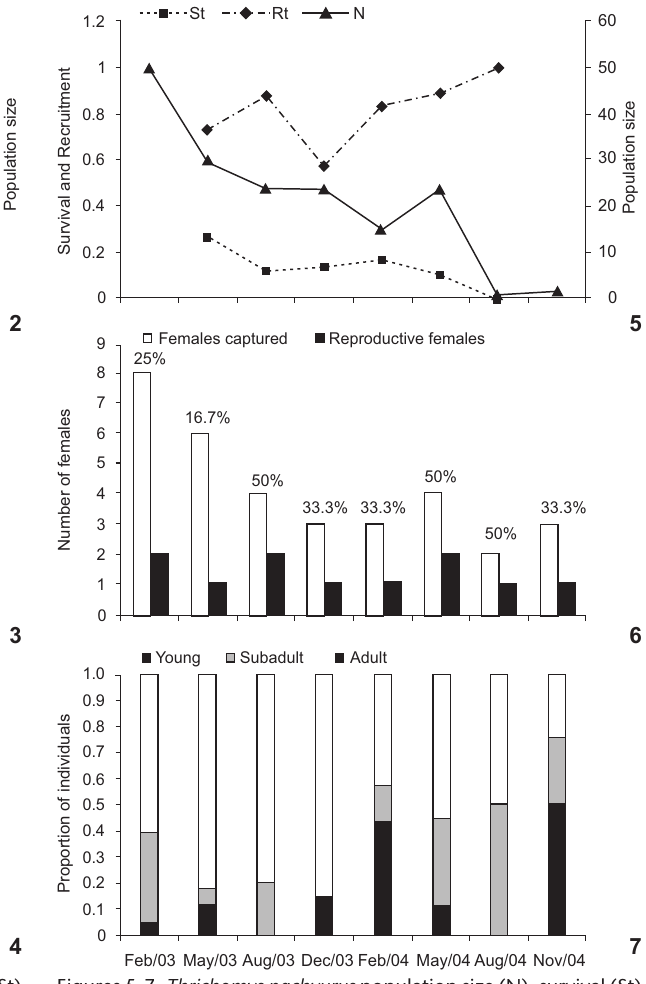
Figures 5-7. Thrichomys pachyurus population size (N), survival (St) and recruitment (Rt) rates (5); total number of females captured, number of reproductive females and the proportion of reproduc- tive females (6); and the proportion of individuals on each age classes (7); in the Rio Negro farm, Aquidauana, from February 2003 to November